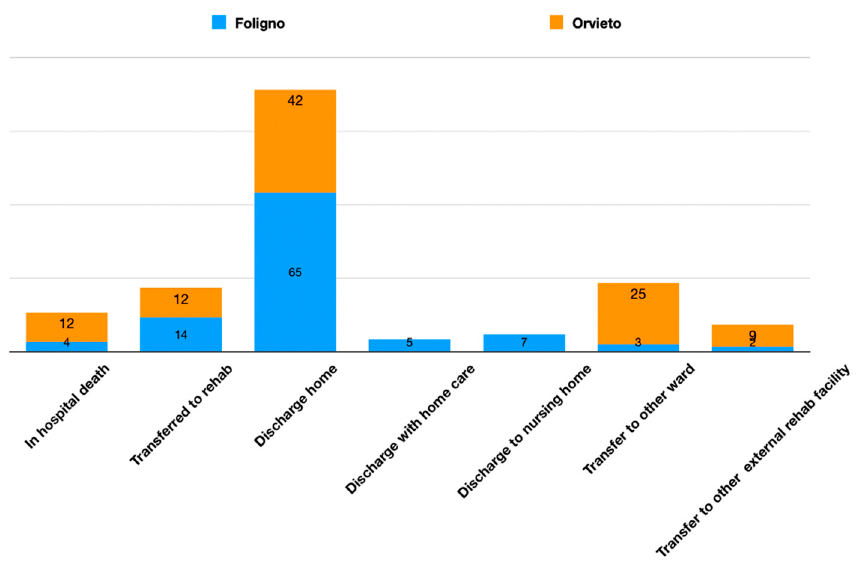
Figure 6. Patients suffering an ischemic stroke treated with tPA and discharge setting. Relative percentages for each hospital.